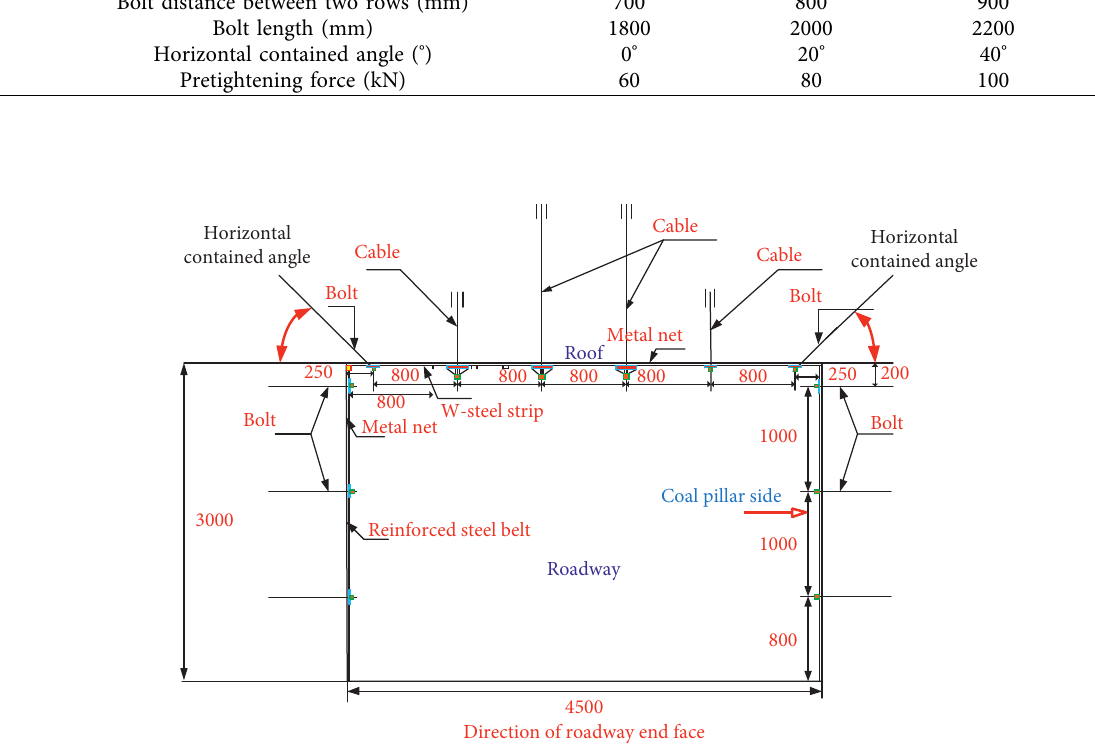
Figure 4: Working state and parameter representation of Table 2: Significance of each factor.